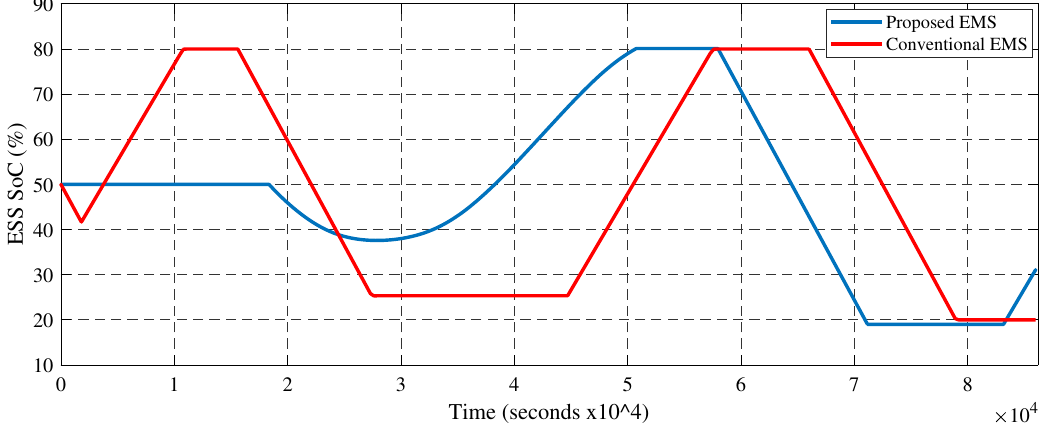
Figure 11. Energy storage system SoC profile.